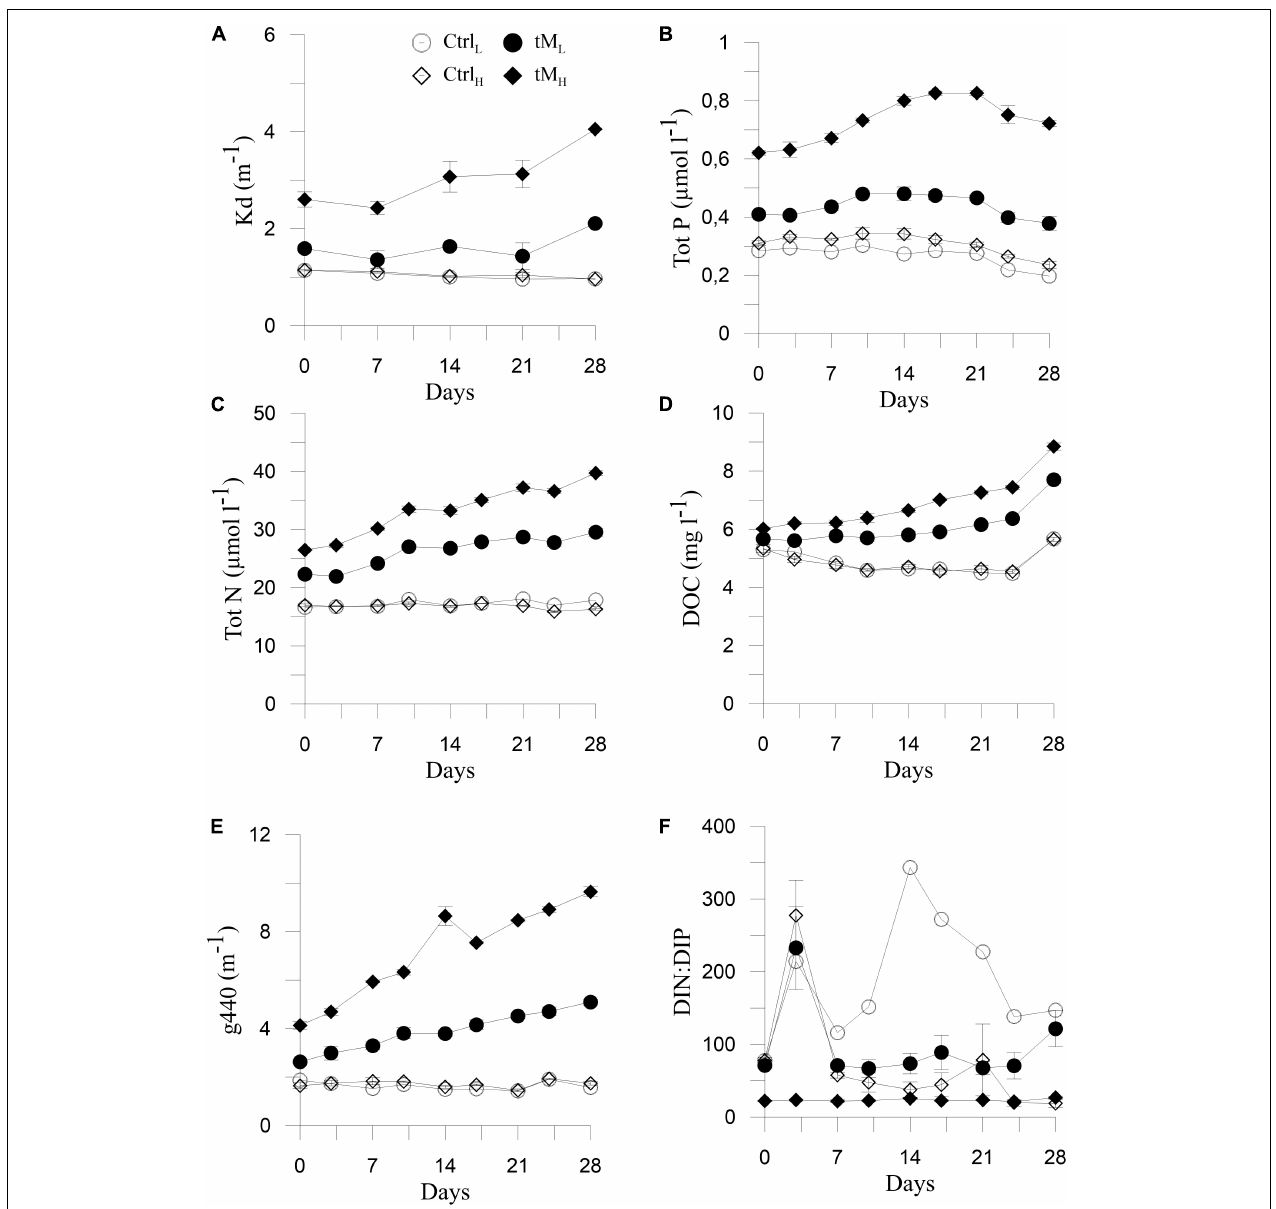
FIGURE 2 | Temporal variation of physiochemical factors: Kd (A) , Tot P (B) , Tot N (C) , DOC (D) modified after Traving et al. (2017), g440 (E) , and DIN:DIP (F) . Mean ± standard error, n = 3.